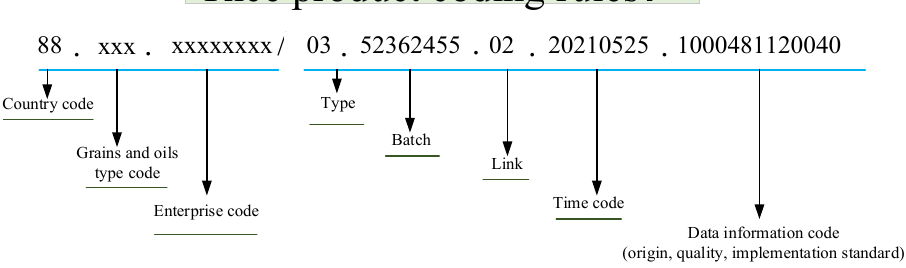
Figure 5. Schematic diagram of identification coding rules.